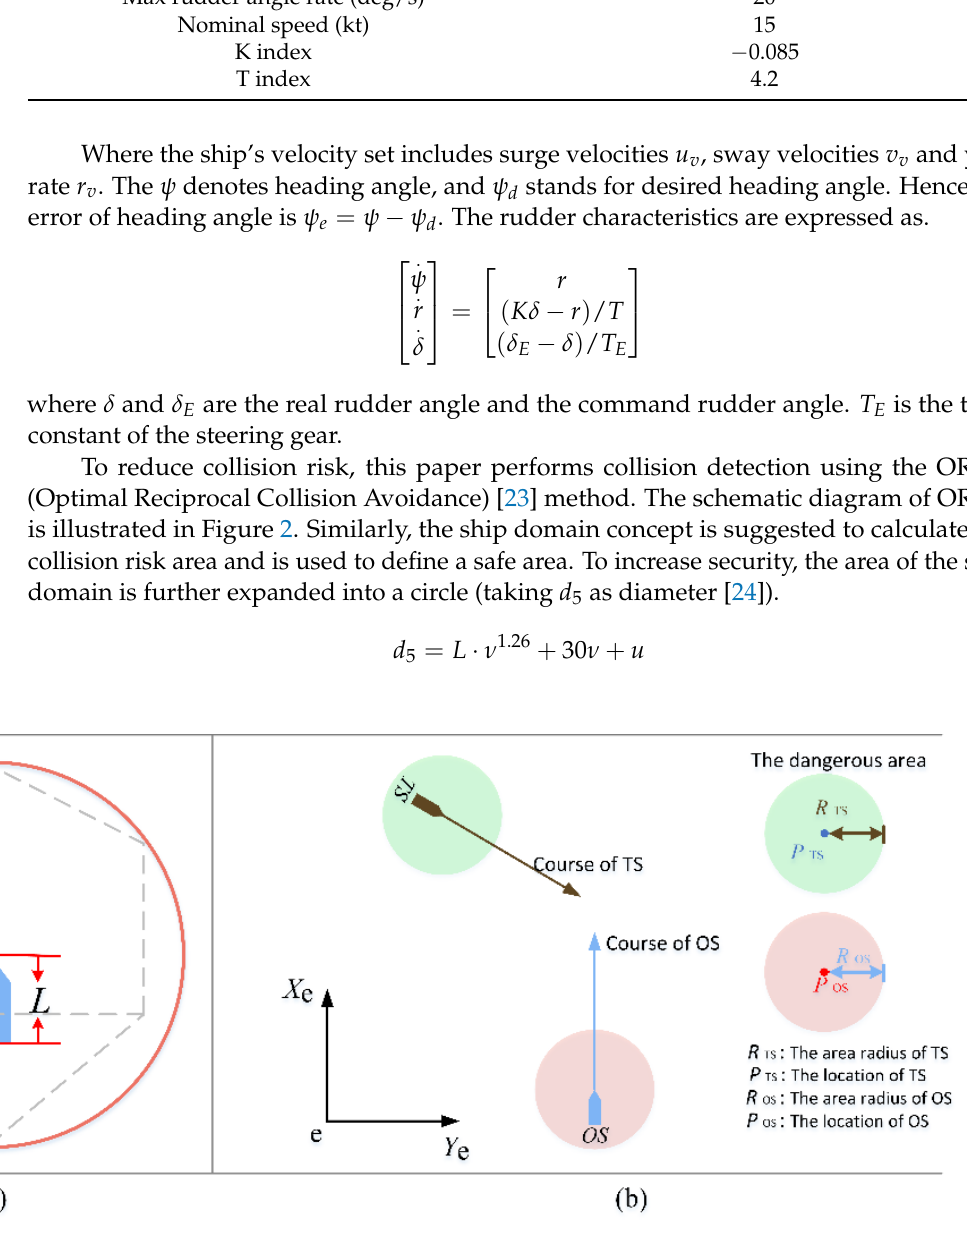
Figure 2. Establish the safe area by designing the ship domain. ( a ) The design of the ship safe domain; ( b ) The information of multi-ship motion.